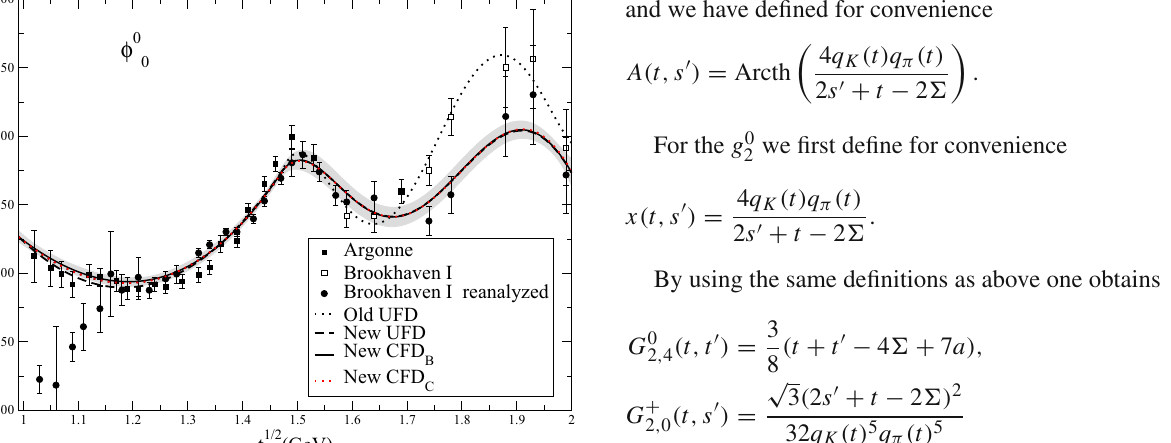
phase obtained after extracting the data from [8] 0 partial wave 2